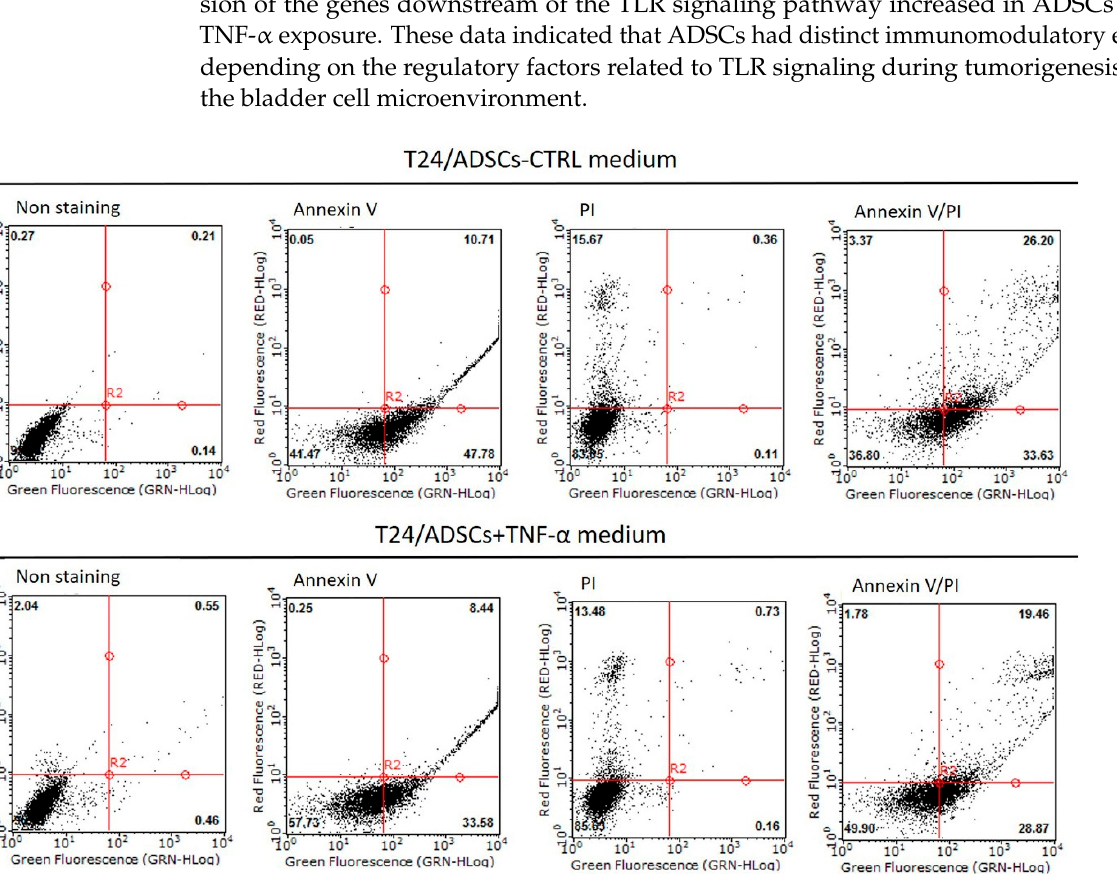
Figure 9. Flow cytometry analysis of ADSCs and TNF- α -treated ADSCs cultured with bladder cancer cells (T24 cells) medium for 24 h.